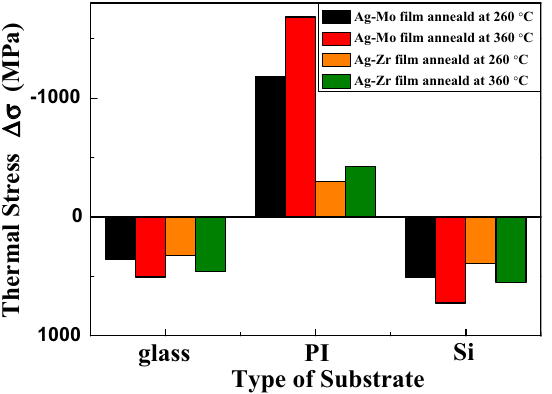
Figure 5: Thermal stress of Ag – Mo and Ag – Zr alloy fi lms on di ff erent substrates annealed at 260°C and 360°C.